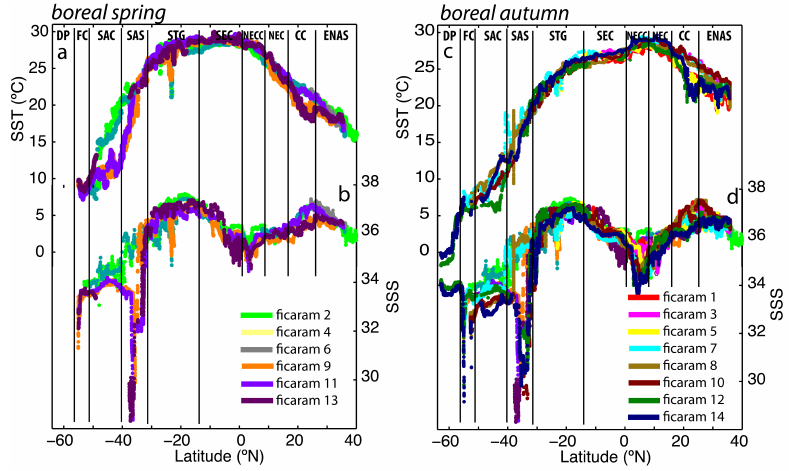
Fig. 2. Latitudinal distributions during boreal springs (a, b) and boreal autumns (c, d) of SST and SSS as measured in the FICARAM cruises.